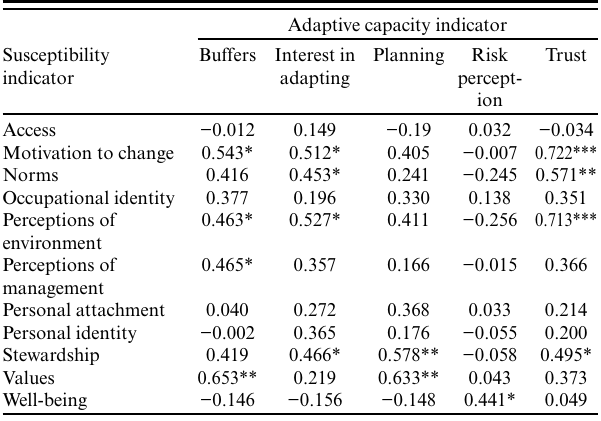
Table 4. Pearson correlations between dimensions of susceptibility and adaptive